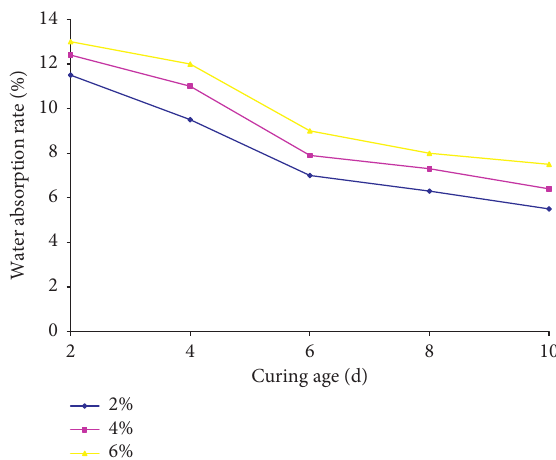
Figure 16: Water absorption ratio of test pieces under various microbial capsule